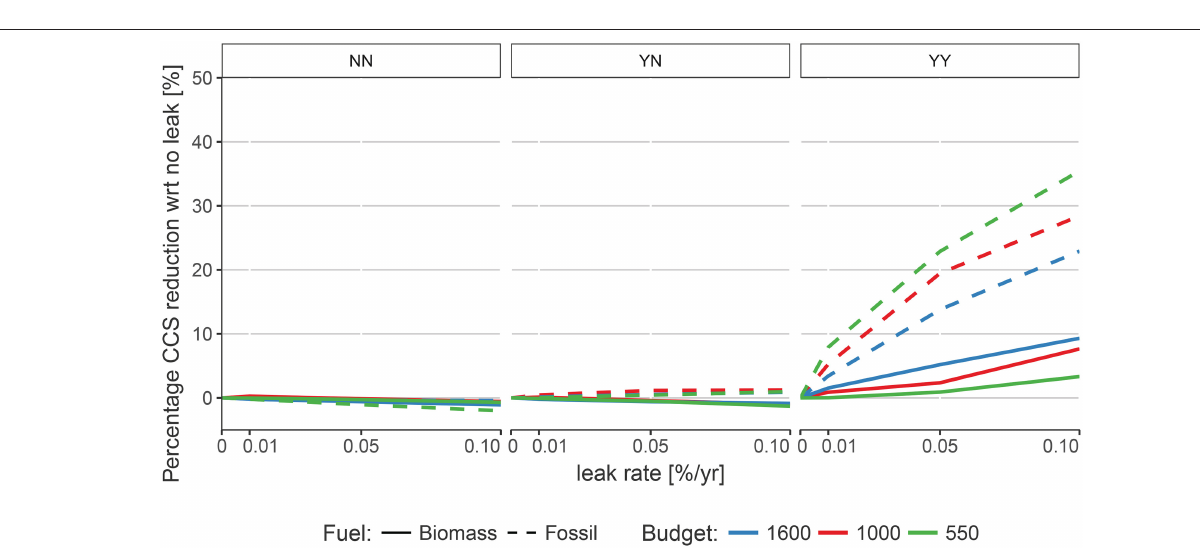
rate of 0.1% per year, especially in the most stringent